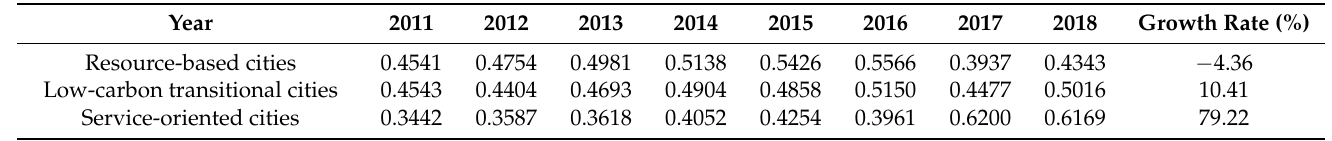
Table 6 calculated by the